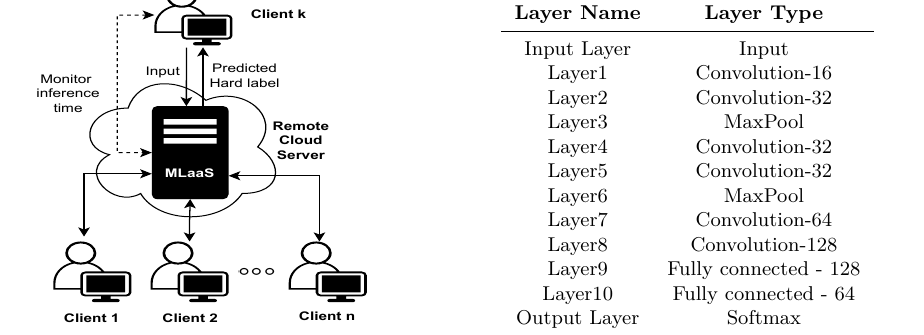
Figure 2: Experimental Scenario: A client having hard-label black-box access to a remote cloud-server providing MLaaS through a CNN implemented on PyTorch.